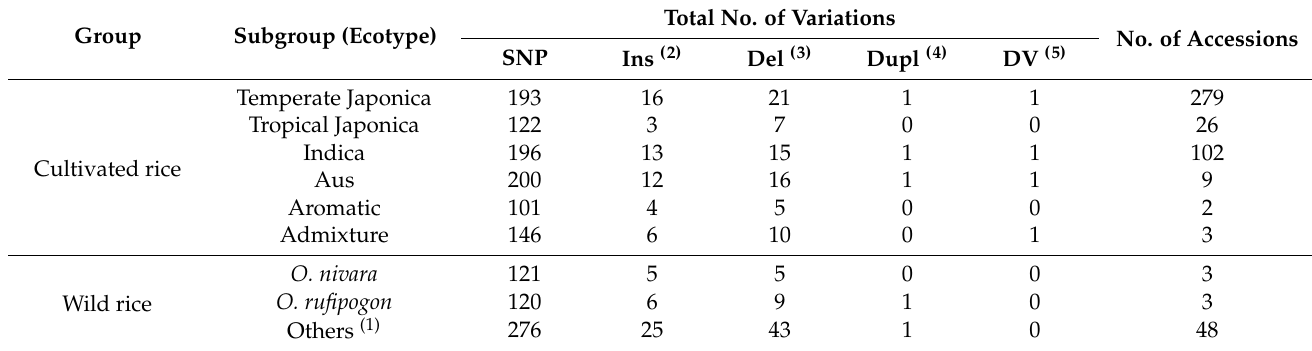
Table 1. Summary of genetic variations in the GBSSII gene region of 475 accessions from the Korean world rice collection. The GBSSII reference gene region was adapted from Nipponbare. Others (1) : group of wild rice accessions other than Oryza nivara and Oryza rufipogon , Ins (2) : insertion, Del (3) : deletion, Dupl (4) : duplication, and DV (5) : different